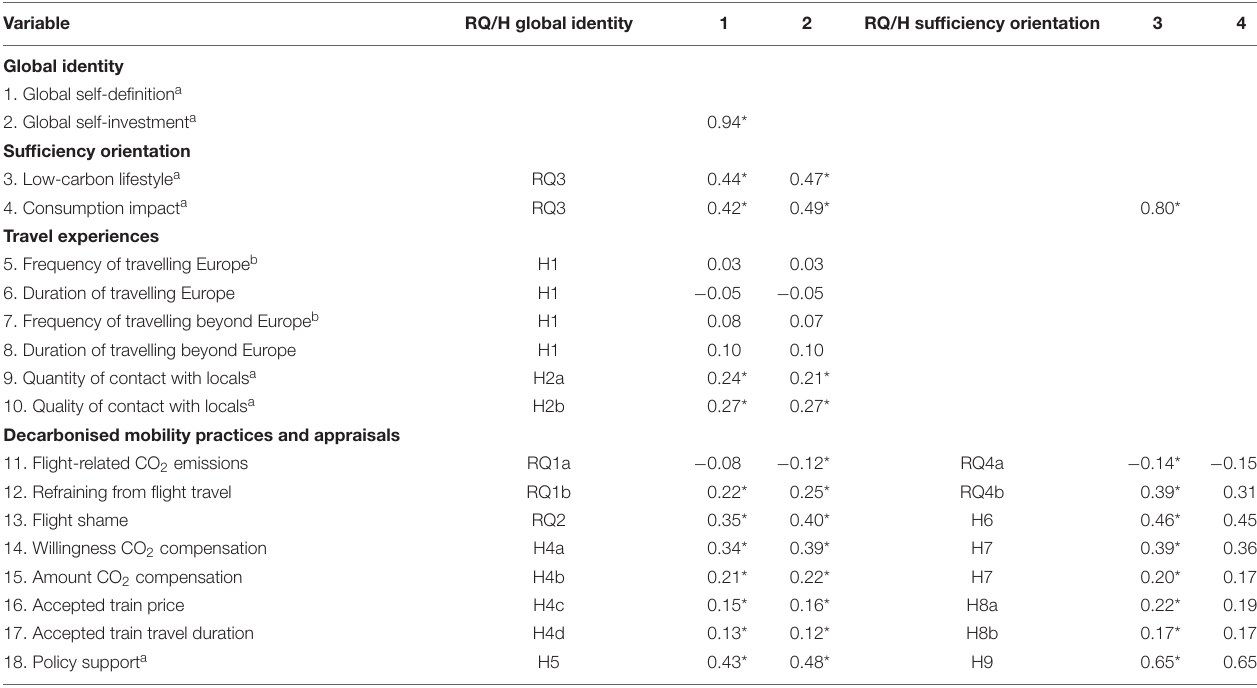
TABLE 1 | Bivariate correlations addressed in our research questions and hypotheses.